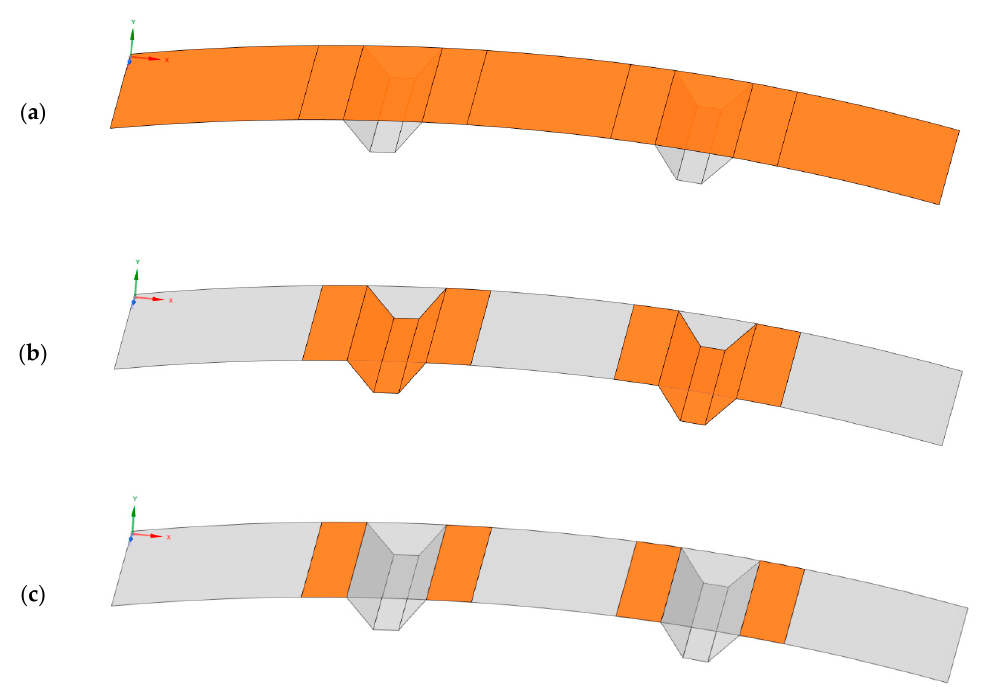
Figure 2. Geometry of the omega-sti ff ened composite panel: ( a ) base part; ( b ) reinforcement part; and ( c ) double-thickness part. Table 1. Ply orientation in di ff erent parts of the laminate (assuming even-symmetry).